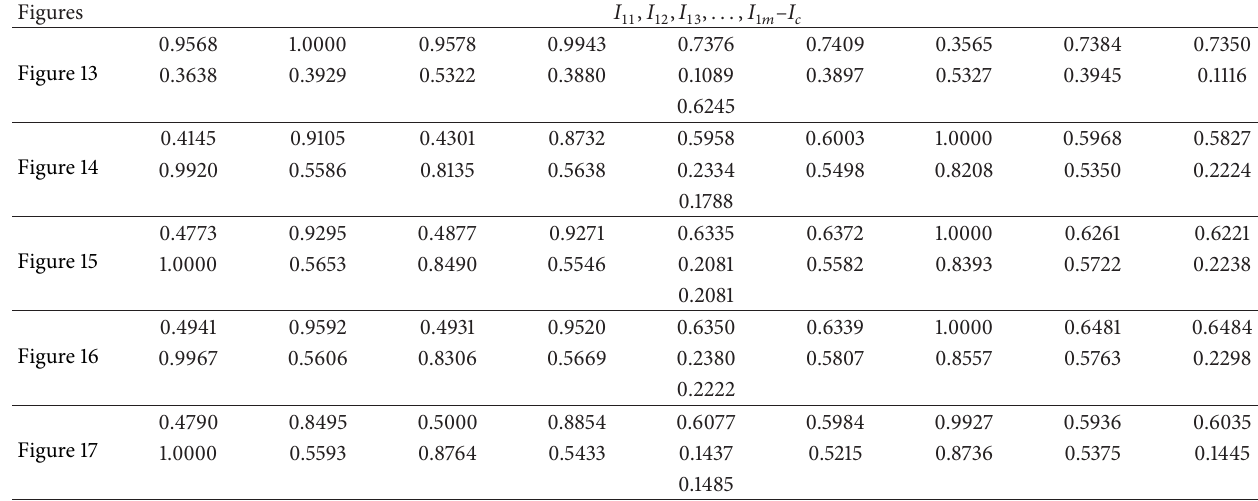
Table 4: The amplitude values calculated by BSA for the CCAAs with central element.